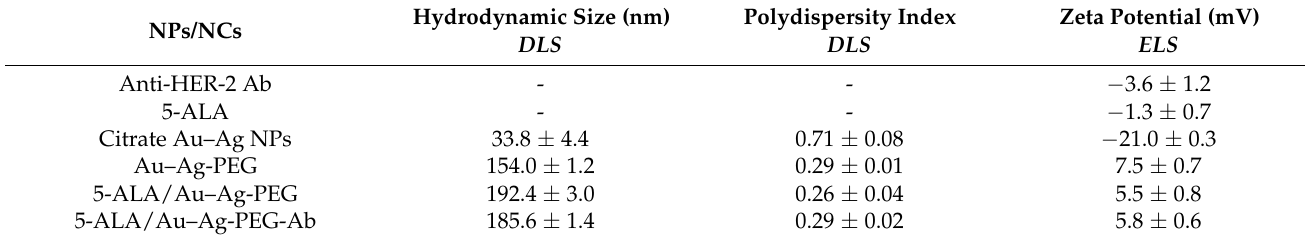
Table 1. Size, hydrodynamic diameter, zeta potential, and polydispersity index of Ab, 5-ALA, and